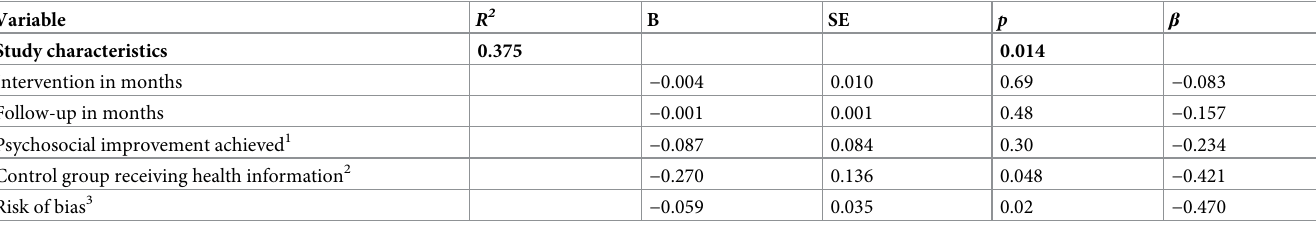
Table 2. Random effects meta-regression of HR estimates of study characteristics on patient